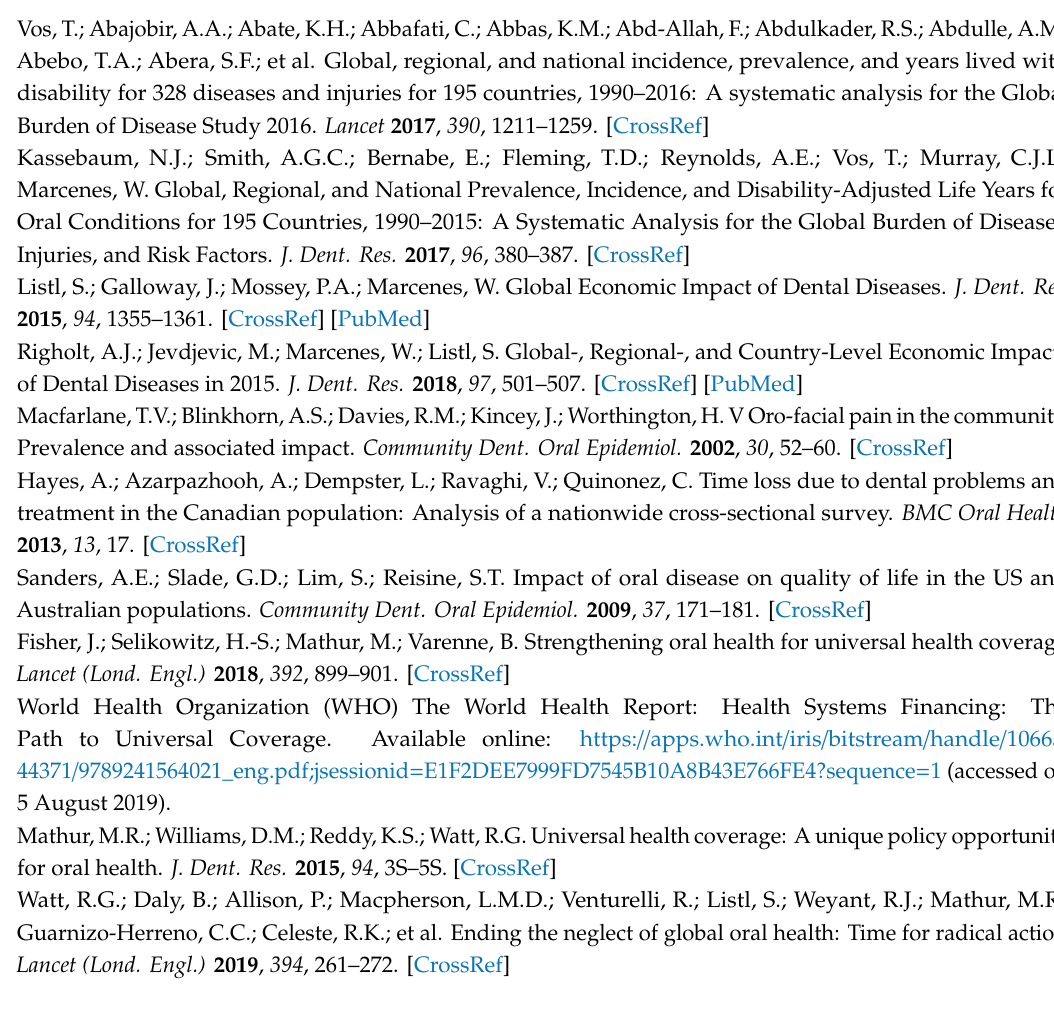
Table S1: The association between DMFT at baseline and increment of newly onset carious teeth (n = 1542); Table S2: The association between DMFT at baseline and individual caries incidence (n = 1542). Author Contributions: T.K., J.A., and K.O.: conception and design. H.T.: acquisition of data All